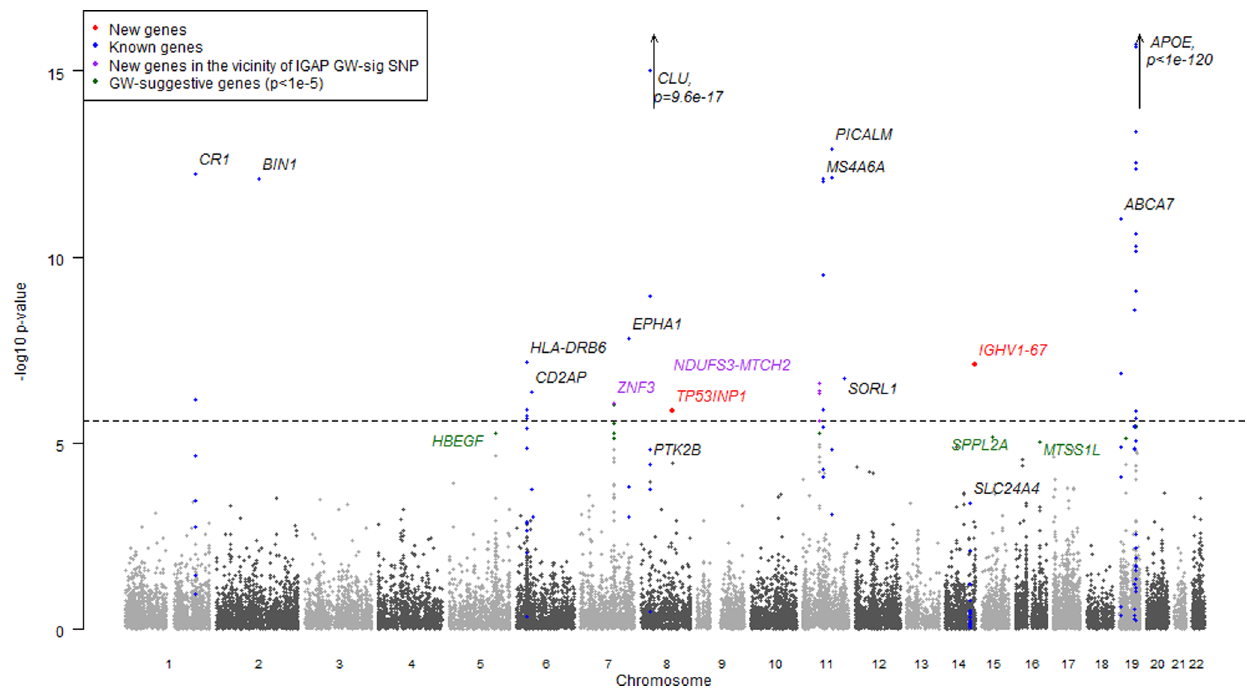
Figure 3. Manhattan plot of gene-wide p-values in the Stage 1 dataset and combined gene-wide p-values where Stage 2 data are available. Each dot represents a gene, genes in blue lie within the previously reported[4–8] associated regions. Table S1 Overrepresentation of significant SNPs ex- cluding previously reported [4-8] genes ± 0.5Mb and the APOE region as above. Table S2 List of genes that are genome-wide significant in the IGAP stage 1 dataset and the flanking regions which included SNPs either in r 2 $ 0.3 or association p- value # 10 -3 whichever covers the largest region. Table S3 Detailed SNP information for TP53INP1 gene. Table S4 Detailed SNP information for IGHV1-67 gene. Table S5 Detailed SNP information for ZNF3 gene. Table S6 Detailed SNP information for NDUFS3 gene. Table S7 Detailed SNP information for MTCH2 gene. Table S8 Gene-based analysis results, when single SNPs p-values, contributing to the gene-based p-value were adjusted for the best genome-wide significant SNP in the nearby location. Table S9 Gene-wide analysis for genes which show GWAS significant association with AD in the stage 1 IGAP dataset.